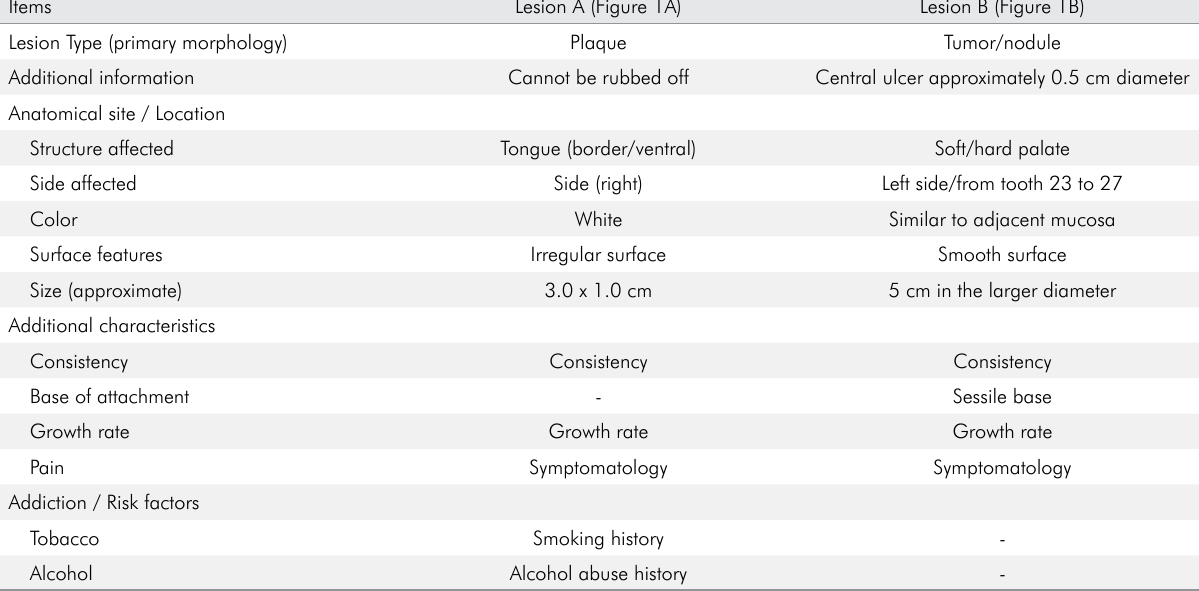
Table 1. Gold standard descriptions for lesions A and